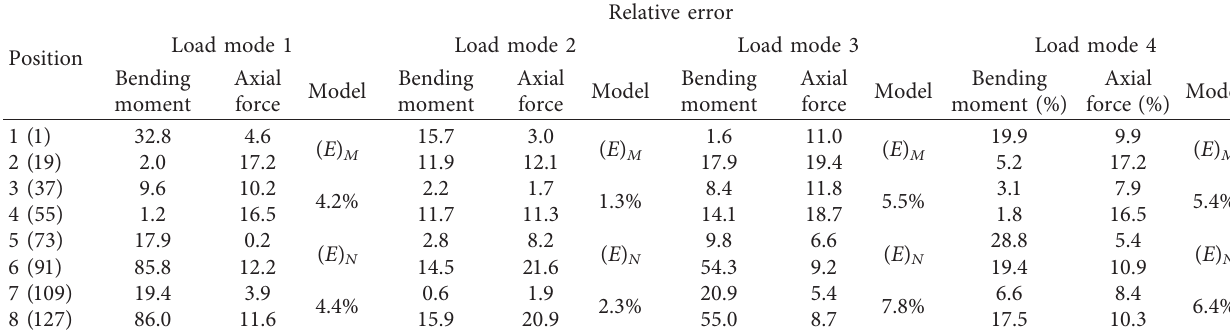
Table 3: Comparison between measured values and finite element